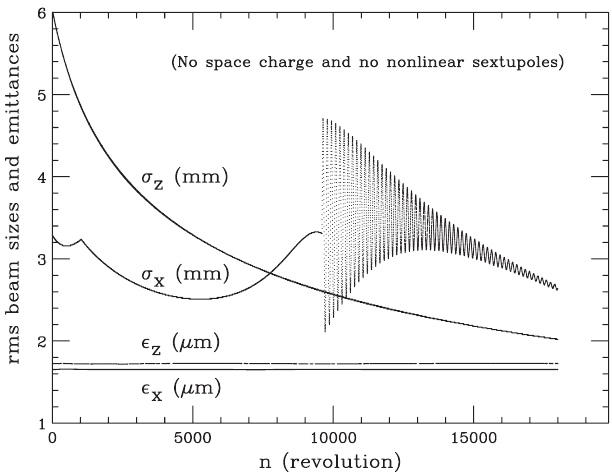
FIG. 28. The emittance is not affected by the linear errors and the coherent beam oscillations due to rf cavities located in dispersive locations.